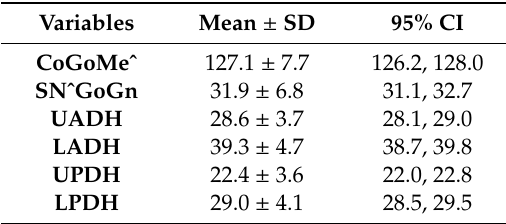
Table 2. Descriptive statistics of the assessed